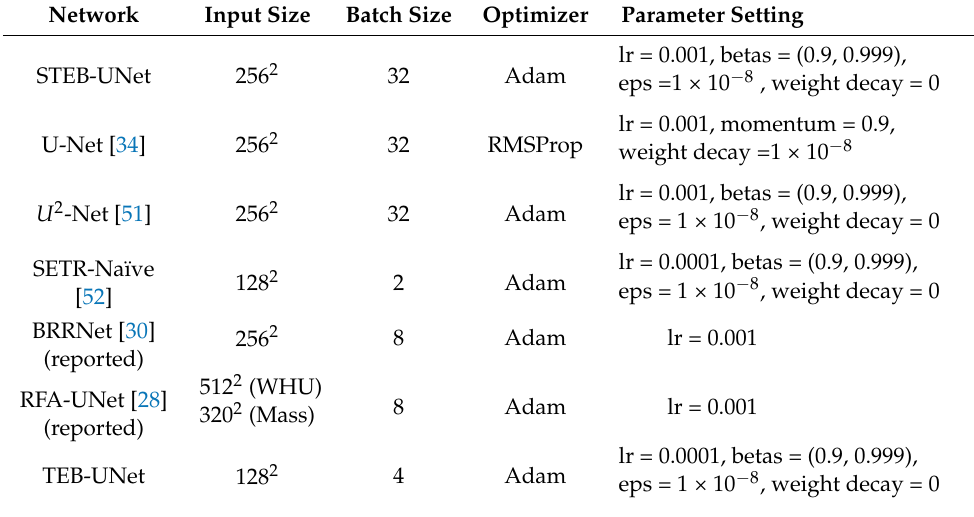
Table 1. Training configurations for different